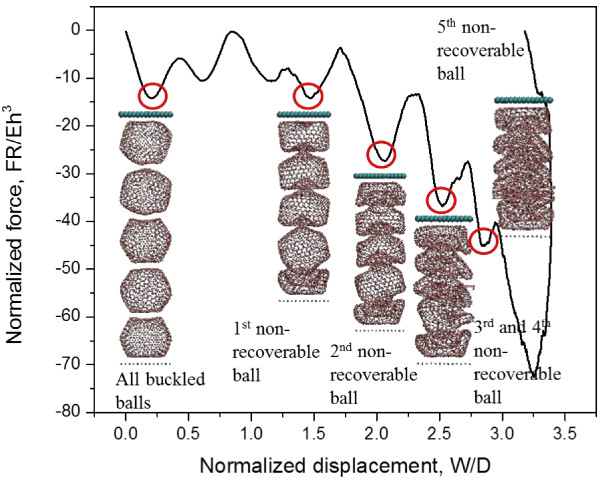
Characteristic normalized force-displacement curve of 1-D system with vertically lined C720buckyballs. The characteristic normalized force-displacement curve of 1-D system with five vertically lined C720s at impact speed of 50 m/s.